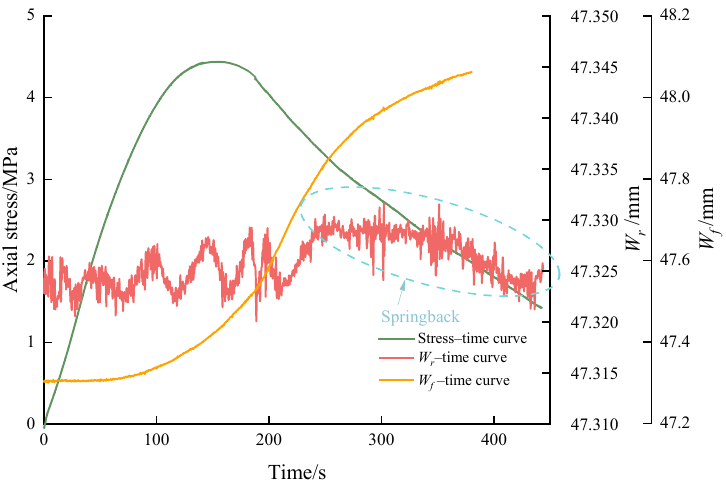
Figure 18. Axial stress, W r , and W f curves of sandstone–CGFB composite samples versus time.